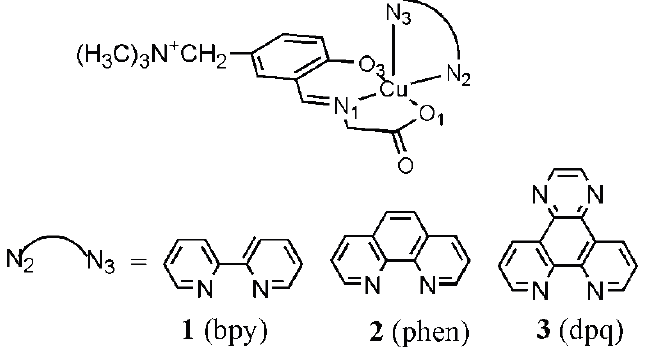
Figure 15. Ternary Cu(II) complexes of cationic Schiff base and diimines. The numbers correspond to the respective Cu(II) complexes [60].